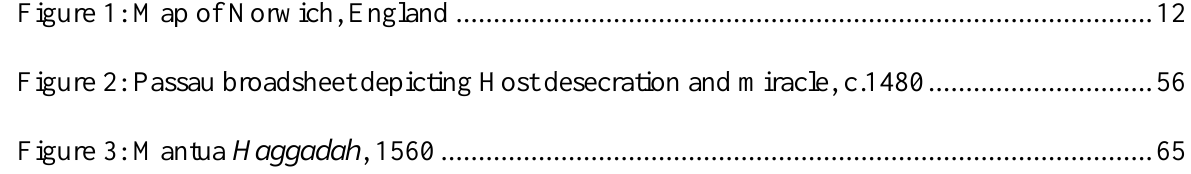
Figure 2: Passau broadsheet depicting Host desecration and miracle, c.1480 .............................. 56 Figure 3: Mantua Haggadah , 1560 ............................................................................................... 65 Figure 4: Illustration of the ritual murder of Anderl von Rinn, from his cult-church,